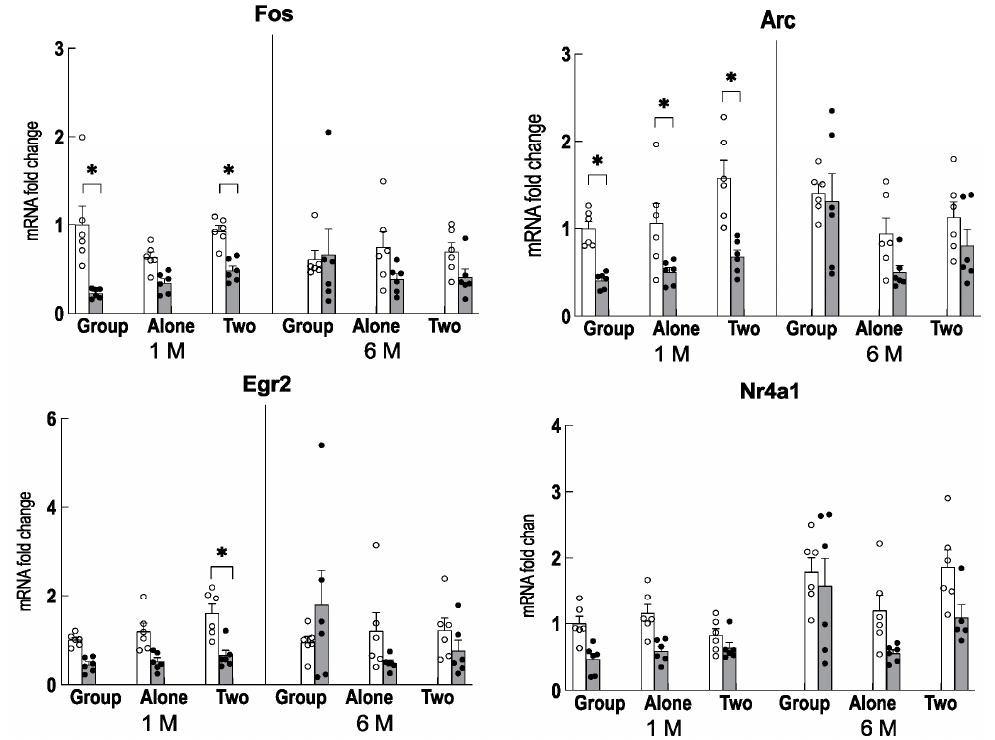
Figure 6. Changes in IEG expression in the hippocampus and cerebral cortex of mice reared for 1 month (1 M, 2 months old) and 6 months (6 M, 7 months old) in each housing condition. Open column: control mice. Closed column: theanine-ingesting mice. Each column bar represents the mean ± SEM (n = 6) overlaid on scatter plots (* p < 0.05, Fisher’s exact probability